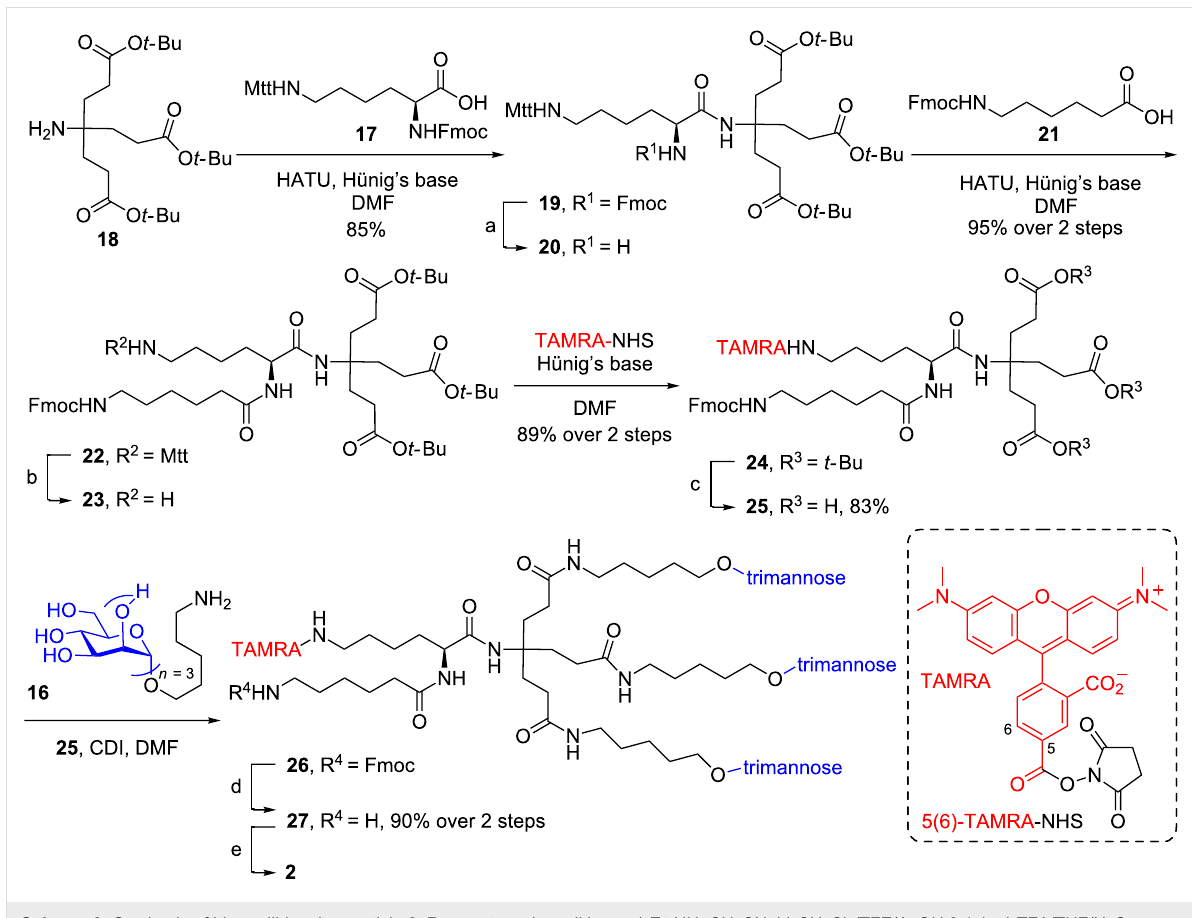
Scheme 3: Synthesis of bioerodible microparticle 2 . Reagents and conditions: a) Et 2 NH, CH 3 CN, b) CH 2 Cl 2 /TFE/AcOH 3:1:1, c) TFA/THF/H 2 O 90:8:2, d) Et 2 NH, DMF, e) CPH/SA microparticles 20:80, EDCI, NHS, H 2